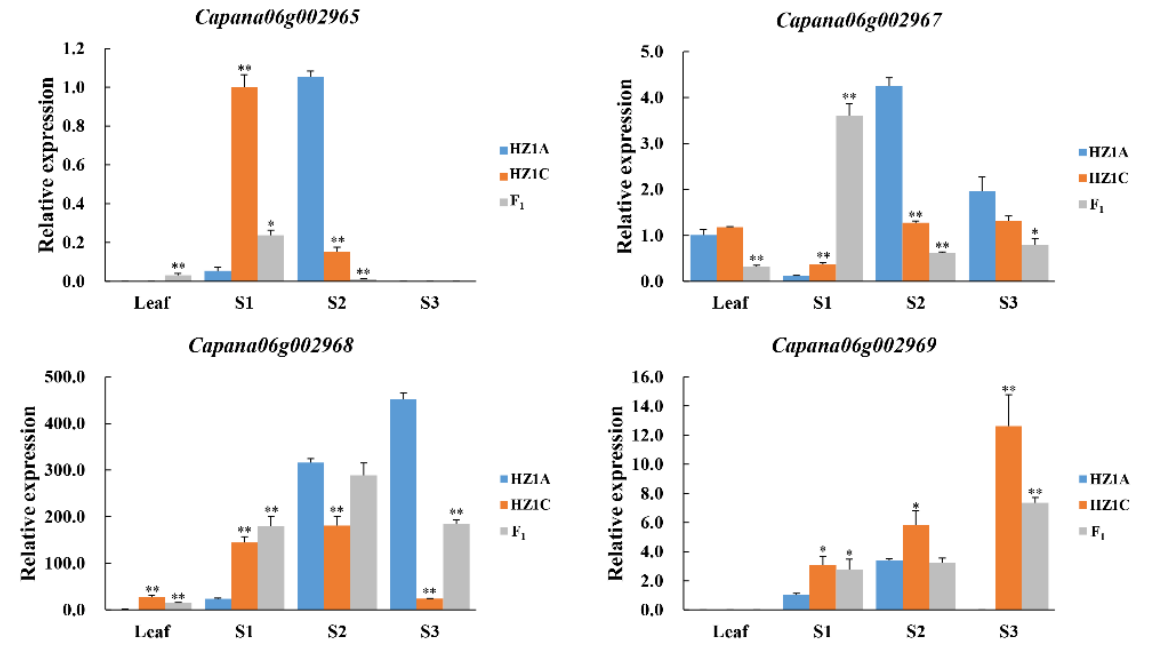
Figure 2. Expression levels of four annotated genes in young leaves and in anthers. * and ** indicate significant difference at p < 0.05 and p < 0.01, respectively.